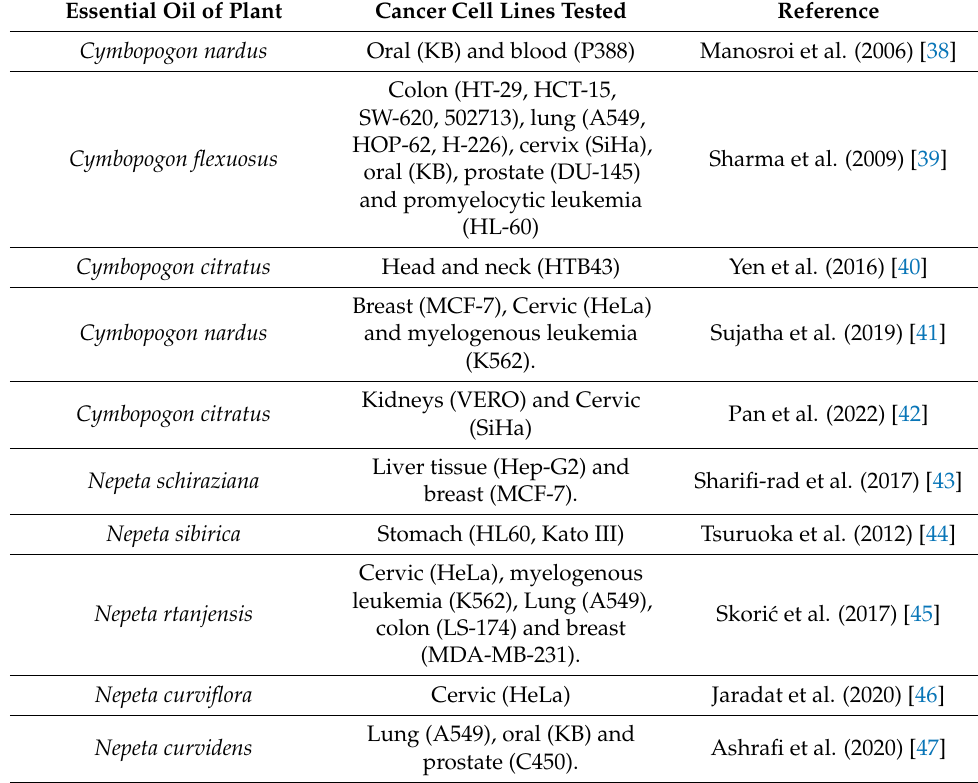
Table 8. Investigation of the anticancer activity of some essential oils of Cymbopogon and Nepeta